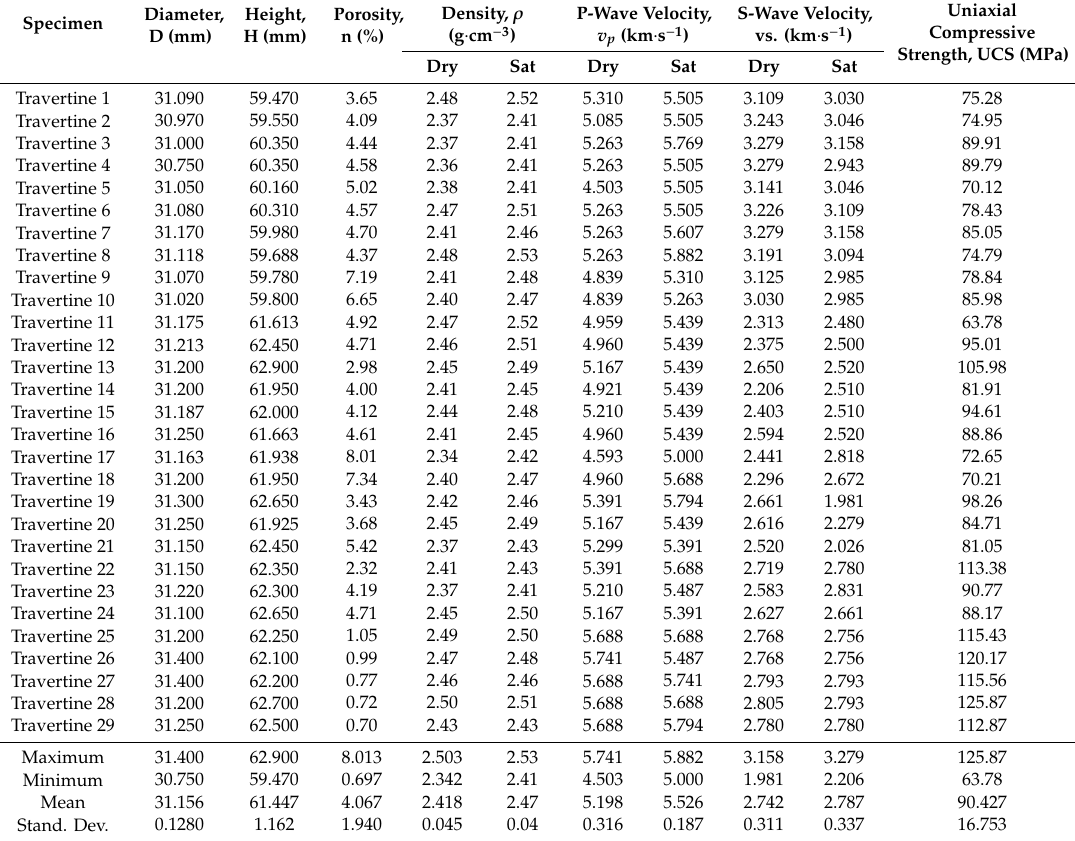
Table 1. Results for geometry, index properties ( v p , v s , ρ y n ) and uniaxial compressive strength (UCS).